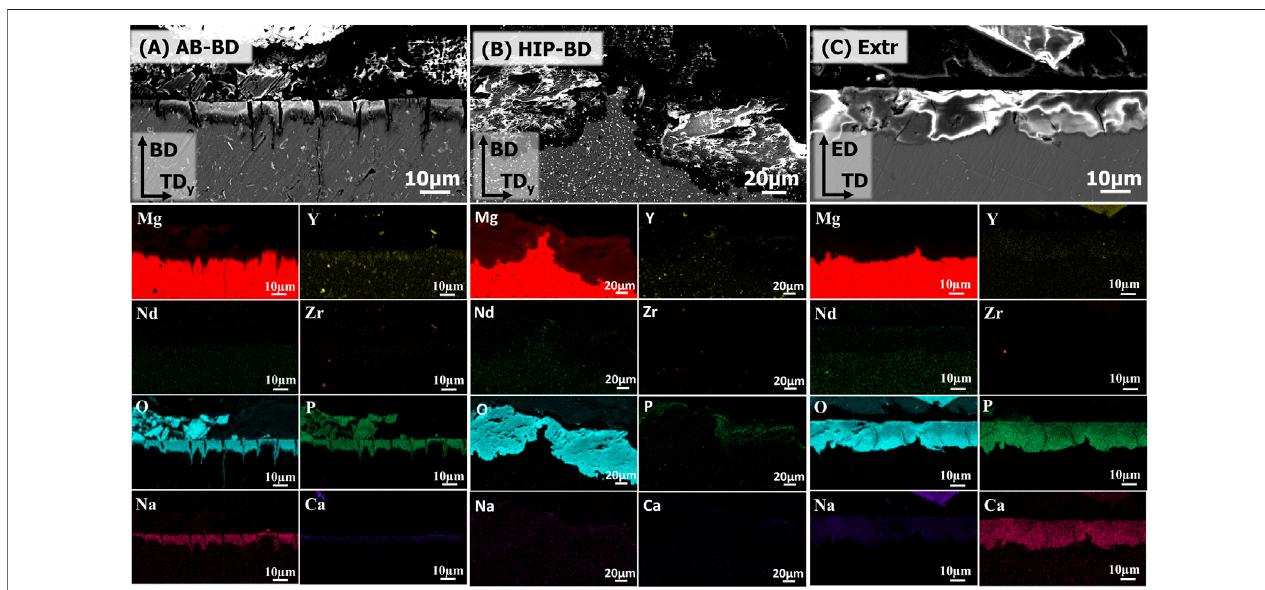
FIGURE12| BSE-SEM imagesofthecross-sectionsofthecorroded (A) AB, (B) HIP and (C) Extrsamples, after28days ofimmersion. TheEDSmaps ofthemain alloying elements (Mg, Y, Nd, Zr) together with the main elements found in the corrosion products (O, P, Na, Ca) are included below corresponding BSE-SEM image.